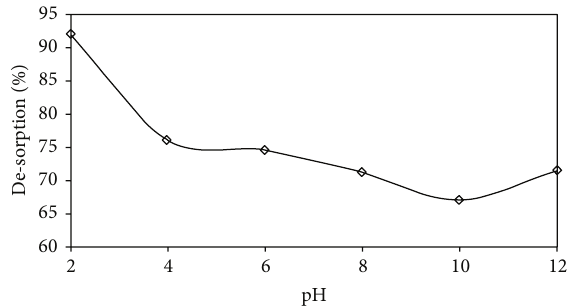
Figure 14: Desorption studies for the removal of AB25. Conditions as in Figure